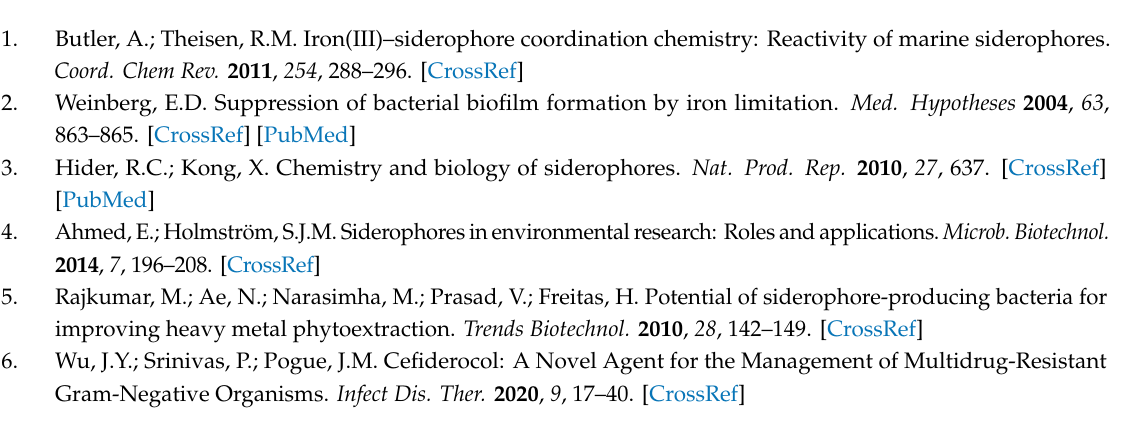
DMSO- d 6 at 600 MHz; Figure S17 : HR-ESI-MS spectrum of desferrioxamine B ( 4 ); Figure S18 : 1 H-NMR spectrum of desferrioxamine B ( 4 ) in DMSO- d 6 at 600 MHz; Figure S19 : HR-ESI-MS spectrum of desoxynocardamine ( 5 ); Figure S20 : 1 H-NMR spectrum of desoxynocardamine ( 5 ) in DMSO- d 6 at 600 MHz; Figure S21 : HR-ESI-MS spectrum of nocardamine ( 6 ); Figure S22 : 1 H-NMR spectrum of nocardamine ( 6 ) in DMSO- d 6 at 600 MHz; Figure S23: 13 C-NMR spectrum of nocardamine ( 6 ) in DMSO- d 6 at 600 MHz; Figure S24: Multiplicity edited HSQC NMR spectrum of nocardamine ( 6 ) in DMSO- d 6 at 600 MHz; Figure S25: 1 H- 1 H COSY spectrum of nocardamine (6) in DMSO- d 6 at 600 MHz; Figure S26: HMBC NMR spectrum of nocardamine ( 6 ) in DMSO- d 6 at 600 MHz; Figure S27 : HR-ESI-MS spectrum of hexahydro-3-[(4-hydroxyphenyl)methyl]-Pyrrolo[1,2-a]pyrazine- 1,4-dione ( 7 ); Figure S28: 1 H-NMR spectrum of hexahydro-3-[(4-hydroxyphenyl)methyl]-Pyrrolo[1,2-a]pyrazine- 1,4-dione ( 7 ) in MeOD at 600 MHz; Figure S29: Multiplicity edited HSQC NMR spectrum of hexahydro-3-[(4-hydroxyphenyl)methyl]-Pyrrolo[1,2-a]pyrazine-1,4-dione ( 7 ) in MeOD at 600 MHz; Figure S30: 1 H- 1 H COSY spectrum of hexahydro-3-[(4-hydroxyphenyl)methyl]-Pyrrolo[1,2-a]pyrazine-1,4-dione ( 7 ) in MeOD at 600 MHz; Figure S31: HMBC NMR spectrum of hexahydro-3-[(4-hydroxyphenyl)methyl]- Pyrrolo[1,2-a]pyrazine-1,4-dione ( 7 ) in MeOD at 600 MHz; Figure S32 : Molecular network of the molecular families F1, F2, F6–F8, F11, and the single nodes 477.2555 [M + H] + , 555.3857 [M + H] + , and 571.3807 [M + H] + . Nodes of isolated compounds ( 1 – 6 ) are shown with solid arrowed lines while dereplicated nodes ( 8 – 16 ) are indicated by dotted arrowed lines. Nodes were represented as pie charts indicating their intensities or percentages in the methanol (red nodes), ethyl acetate (blue nodes), and dichloromethane (green nodes) extracts of the fermentation broth of K. speibonae strain SK5. Nodes with asterisk (*) indicate dehydroxylated desferrioxamines; Figure S33: A MN showing a link between nodes di desoxy-desferrioxamine D 1 8 (571.3807 [M + H] + ) and desoxy-desferrioxamine D 1 2 (587.3754 [M + H] + ) when default parameters were used in generating the MN on the GNPS platform; Figure S34: MS / MS spectrum of desoxy-desferrioxamine D 1 2 (587.3754 [M + H] + ) with annotation in the structure; Figure S35: MS / MS spectrum of di desoxy-desferrioxamine D 1 8 (571.3807 [M + H] + ) with annotation in the structure; Figure S36: MS / MS spectrum of speibonoxamine 1 (555.3857 [M + H] + ) with annotation in the structure; Figure S37: MS / MS spectrum of desferrioxamine B 4 (561.3606 [M + H] + ) with annotation in the structure; Figure S38: MS / MS spectrum of desoxy-desferrioxamine B 9 (545.3654 [M + H] + ) with annotation in the structure; Figure S39: MS / MS spectrum of di desoxy-desferrioxamine B 10 (529.3702 [M + H] + ) with annotation in the structure; Table S1: Compounds isolated and tentatively identified in the molecular cluster and the MS chromatogram of the fermentation broth of K. speibonae strain SK5 with their corresponding masses, molecular formulae (MF), double bond equivalent (DBE), retention time (Rt), and mass error (ID ( ∆